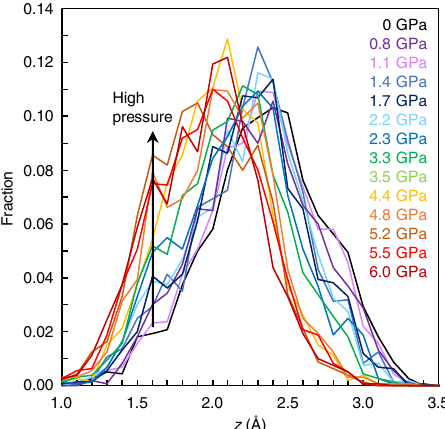
Fig. 2 Translational order in SiO 2 glass as a function of the parameter z with varying pressure. The parameter z is de fi ned as z = δ ji − δ j ′ i , where δ ji and δ j ′ i is the distance from each silicon atom i to the fi fth nearest silicon neighbor j and to the fourth nearest oxygen neighbor j ′ , respectively 4 . Source data are provided as a Source Data fi le.